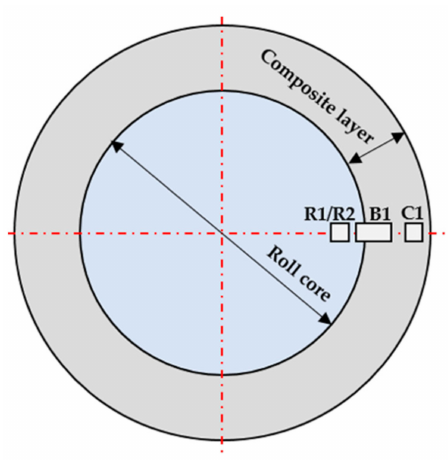
Figure 2. Sampling schematic of roll core, composite layer, and bimetallic bonding